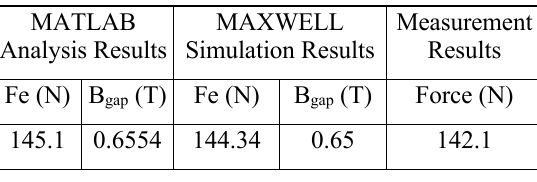
Table 2: Electromagnet results for air gap = 5